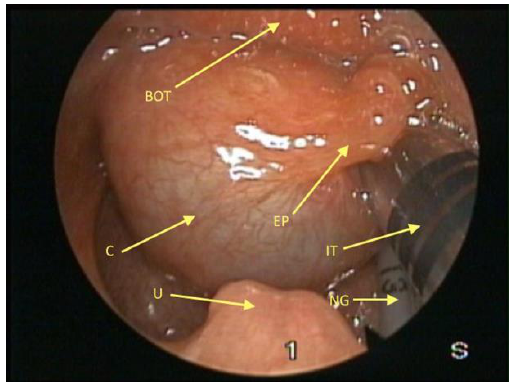
Figure 2: Preoperative endoscopic view of the larynx (BOT; Base of tongue, EP; Epiglottis, C; Cyst, U; Uvula, ET; Endotracheal tube, NG; Nasogastric